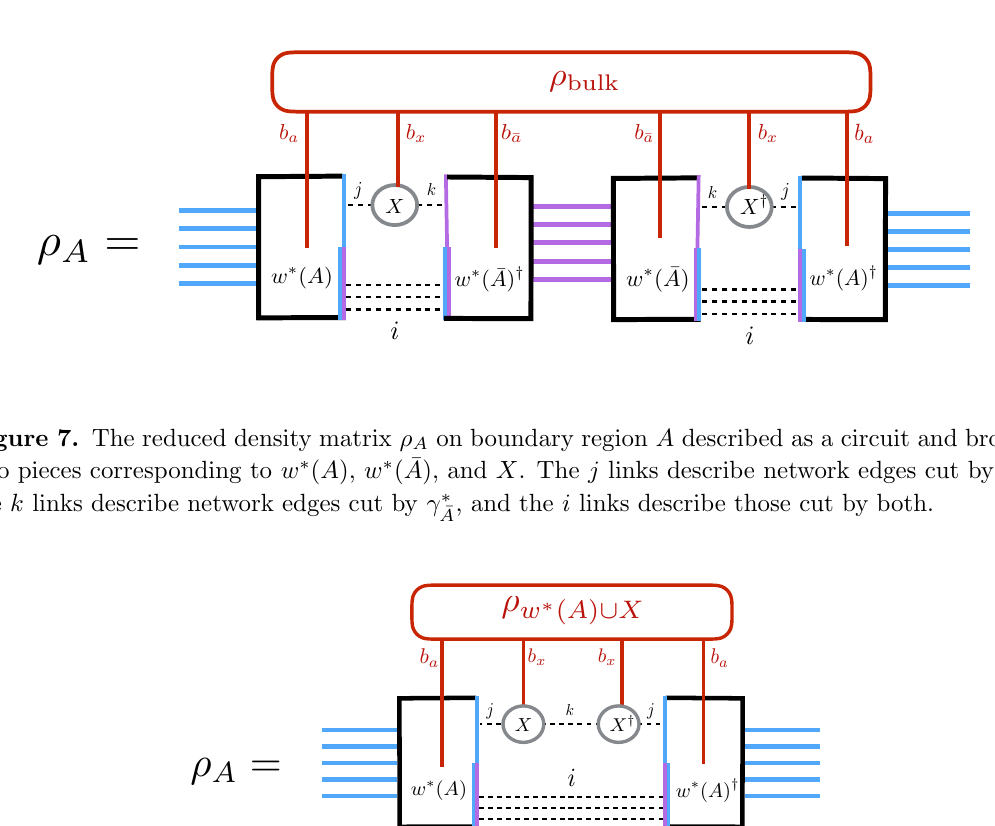
Figure 8. A simpler network for (cid:26) A obtained from (cid:12)gure 7 by using the fact that w (cid:3) ( an isometry from the indices k , i , and b (cid:22) a to the boundary (cid:22) A .